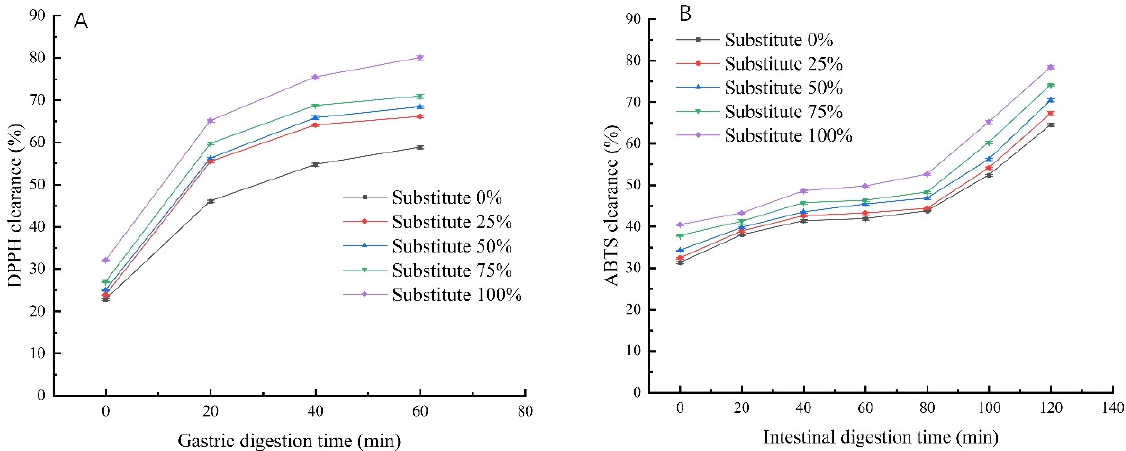
Figure 6. Effect of replacing milk fat with SOBs on antioxidant activity of yogurt: ( A ) DPPH clearance rate ( B ) ABTS clearance rate.